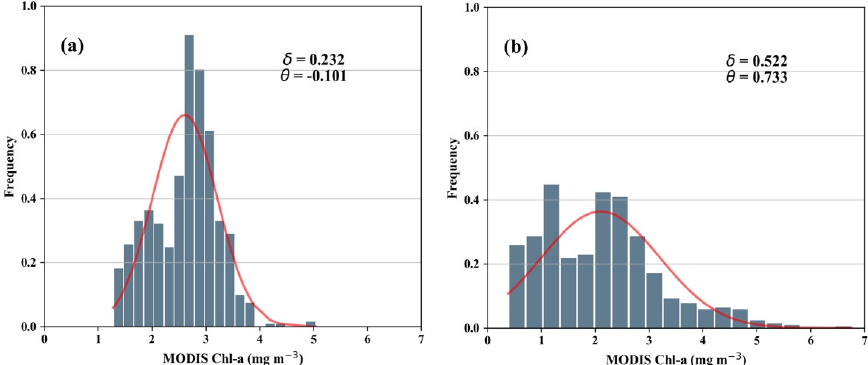
Figure 8. Histogram and fitted normal distribution of MODIS Chl-a for ( a ) the winter day (2016.2.2) and ( b ) the summer day (2016.8.4). δ and θ are the coe ffi cient of variation (COV) and skewness coe ffi cient, respectively. Note that the COV and skewness coe ffi cient values for a normal distribution are zero. The skewness coe ffi cient indicates that the distribution of the summer day data presents more non-normality than that of the winter day.